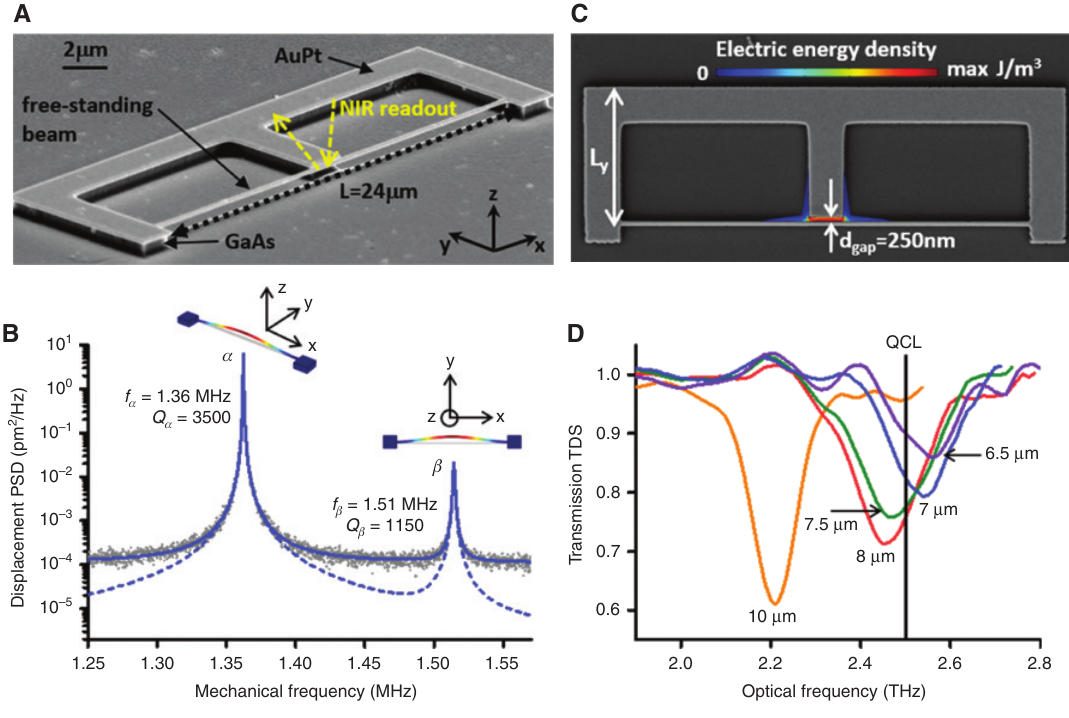
Figure 1: THz optomechanical meta-atom. (A) Scanning electron micrograph of the double-split-ring resonator (DSR). (B) Measured thermo-mechanical (Brownian) noise power spectral density (PSD) of the beam showing the resonances that correspond to first-order flexural modes (dotted curve). The cartoons are finite element method (FEM) simulations of the modes. The blue dashed curve is a model based on Ref. [1]; the blue solid line takes into account the noise floor of the spectrum analyzer (see Supplementary Material). (C) Top-view scanning electron micrograph image of the device. Superposed is a FEM simulation of the electric energy density distribution at resonance. (D) THz time domain spectroscopy transmission spectra of 1.5 × 1.5 mm 2 arrays of identical devices. Each spectrum is identified by the value of the length L The straight black line shows the emission frequency of our THz QCL